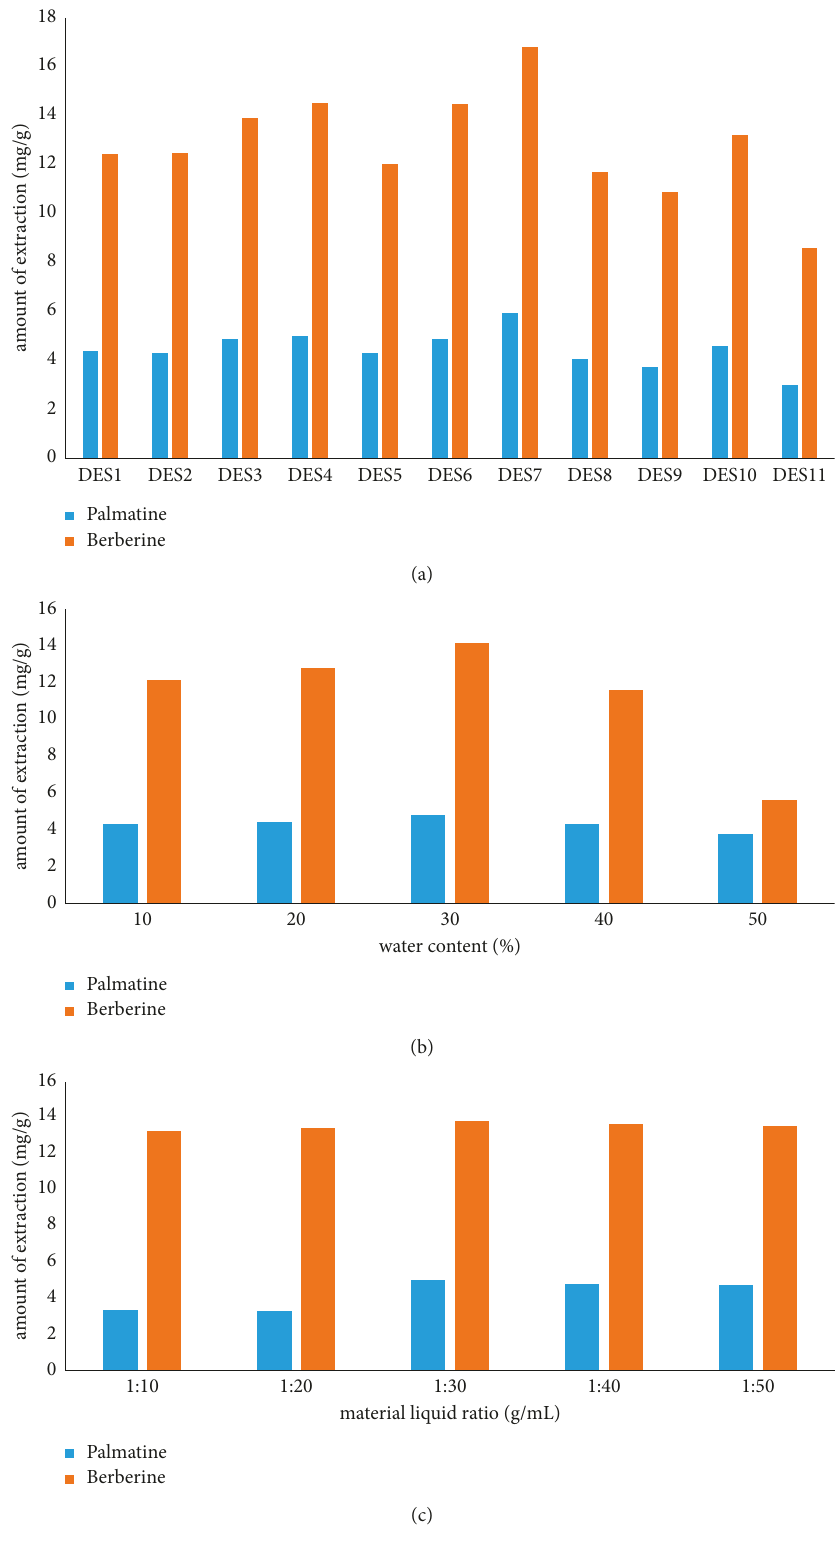
Figure 1: Effect of DES on PcS extraction efficiency: (a) effect of different types of DESs, (b) effect of DES water content, and (c) effect of solid-liquid